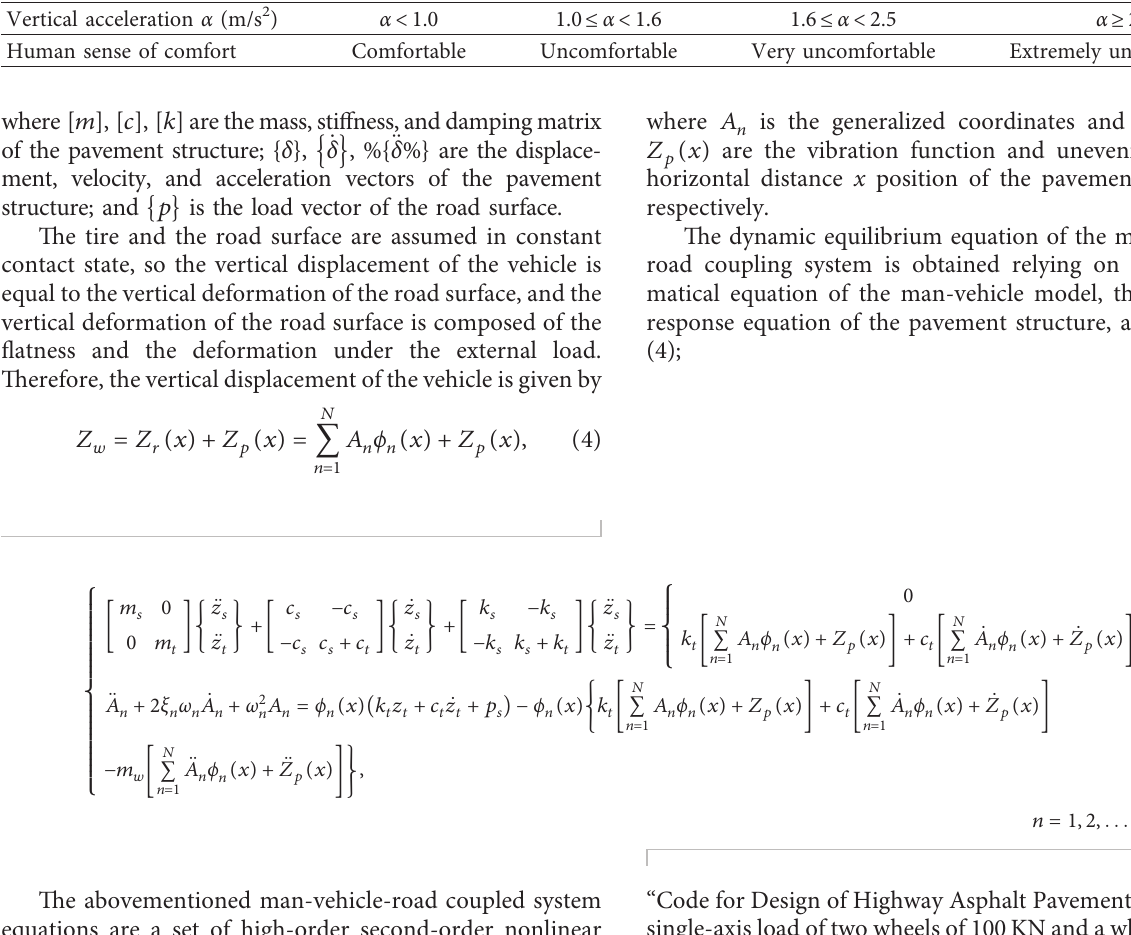
Table 1: Driving comfort control